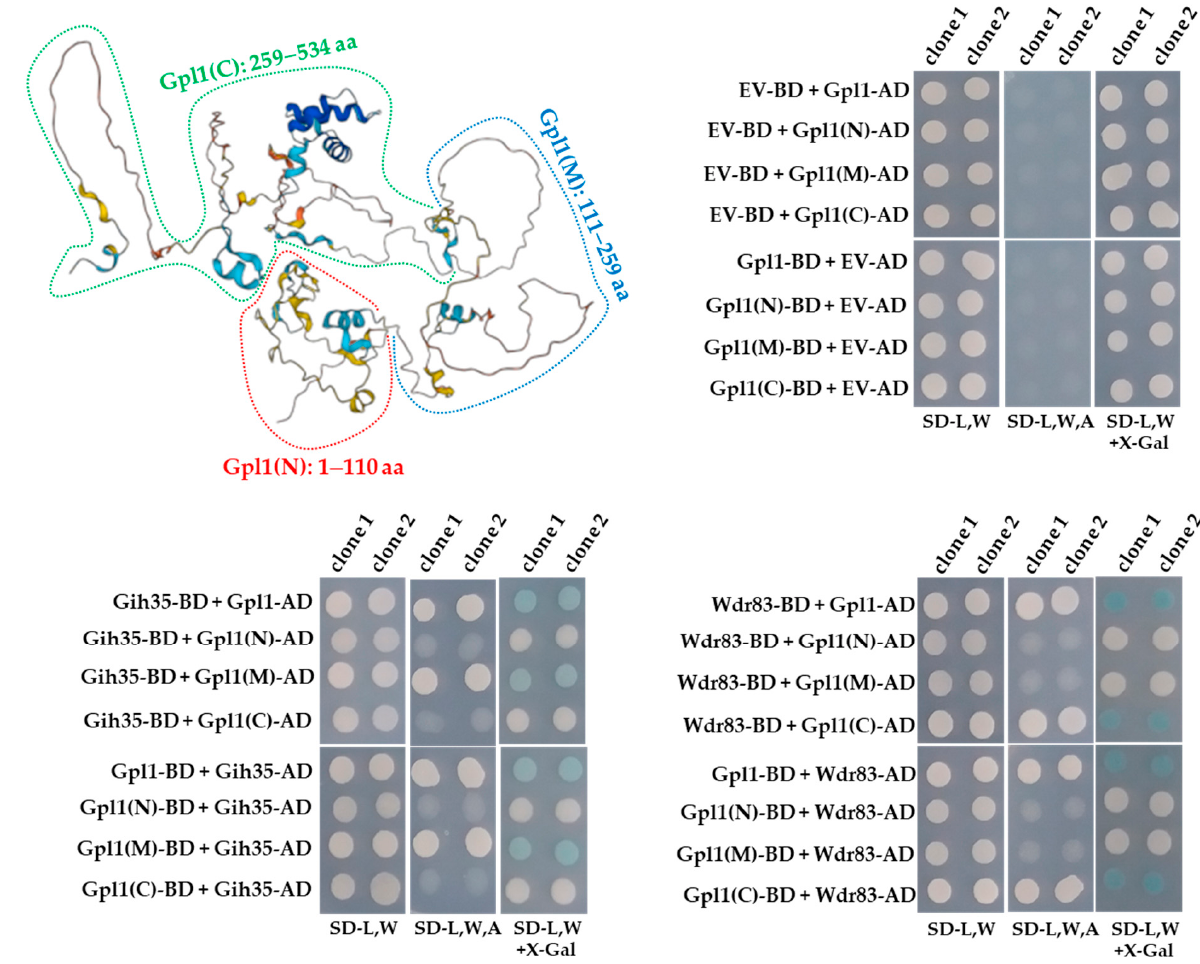
Figure 3. Predicted structure of Gpl1 and Y2H analysis of interactions between Gpl1 and its truncated forms and Gih35 or Wdr83 proteins. The three-dimensional structure of Gpl1 was predicted using AlphaFold [48,49] and downloaded from the AlphaFold Protein Structure Database (https://alphafold.com/entry/Q9HE07, accessed on 28 July 2022). The truncated forms are indicated (Gpl1(N): 1–110 aa, red dashed line; Gpl1(M): 111–259 aa, blue dashed line; Gpl1(C): 259–534 aa, green dashed line). G-patch domain is located within the N-terminal region of Gpl1 (36–110 aa). EV-BD or EV-AD and protein-BD or protein-AD indicate empty Y2H vector bearing binding or activation domains and Y2H vectors expressing protein of interest fused with binding or activation domains, respectively. SD-L,W—synthetic dropout media without leucine and tryptophan; SD-L,W,A—synthetic dropout media without leucine, tryptophan and adenine; SD-L,W—synthetic dropout media without leucine and tryptophan and supplemented with X-gal.